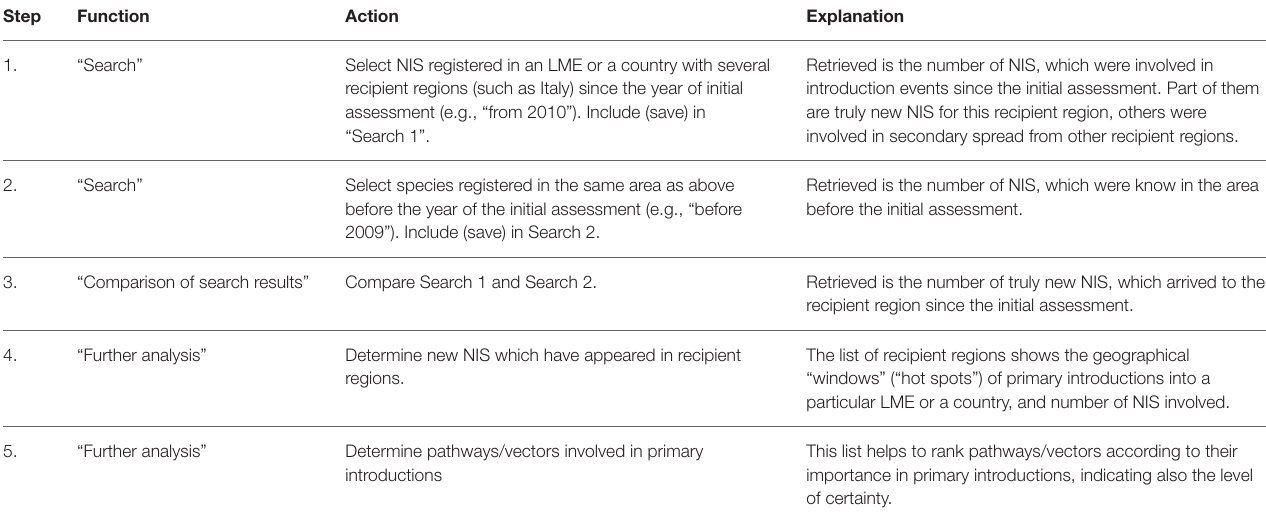
TABLE 1 | Standard data extraction procedure for nNIS L2 and L3 based on the built-in AquaNIS functions.